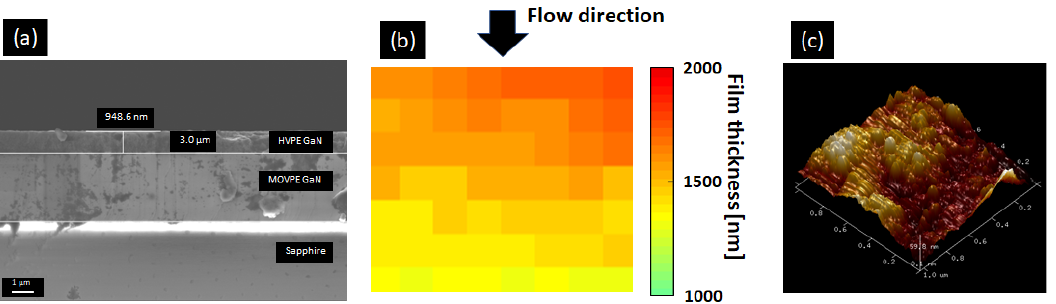
Figure 4. ( a ) Cross-section SEM image shows the thickness of the HVPE layer. ( b ) WLRS thickness map. The thickness varies in the region 1300 – 1740 nm. The top of the figure is closest to the plasma source. ( c ) AFM image taken over 1 µm × 1 µm area. source. ( c ) AFM image taken over 1 µm × 1 µm area.